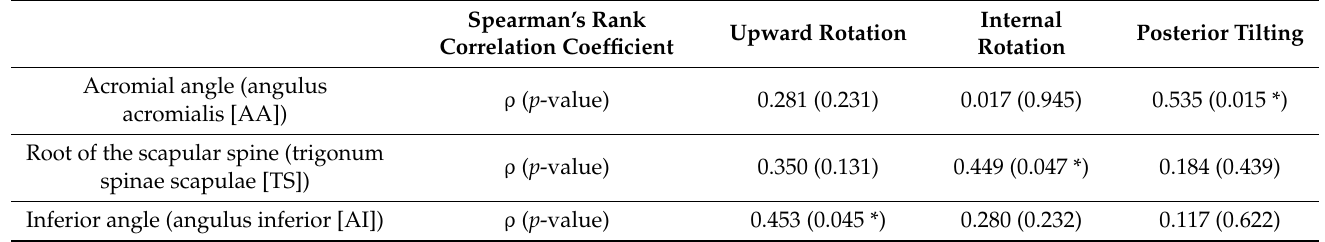
Table 1. The correlation between the marker movement distances and the differences between the bone-based and marker-based scapulothoracic rotation angles in the elevated position. * p < 0.05. Internal Spearman’s Rank Posterior Tilting Upward Rotation Rotation Correlation Coefficient Acromial angle